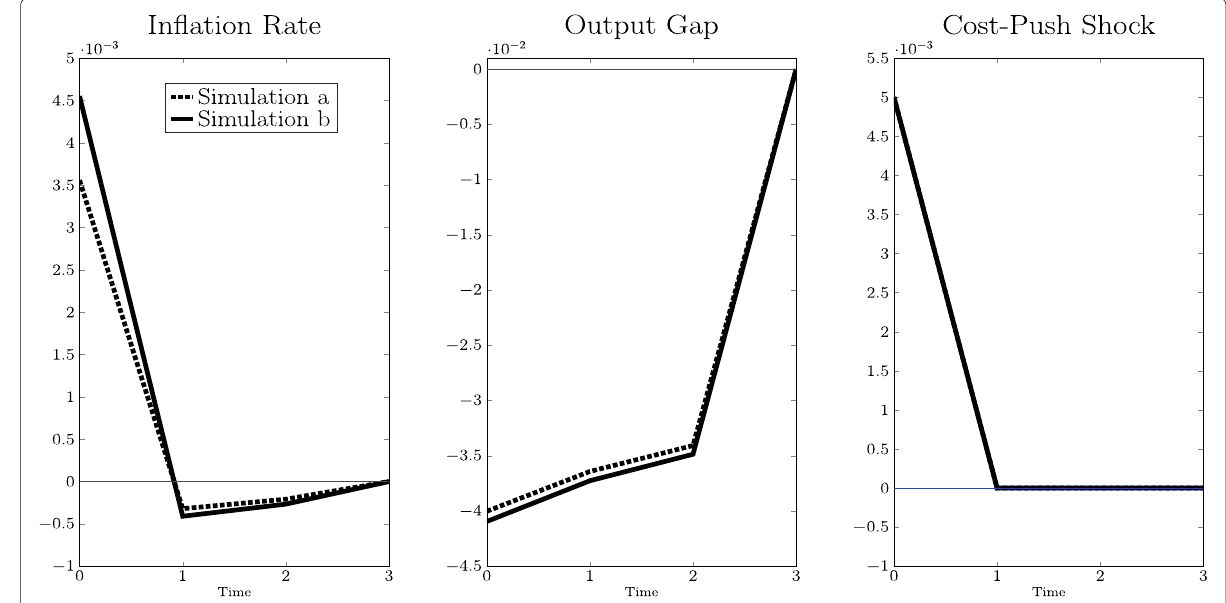
(cid:15) (cid:16) T + 1 γ a = { 1,1,1,0 } and simulation b (solid lines) assumes central bank credibilities t t = 0 } T + 1 = { H ,0,0,0 } and ρ = 0. To highlight the difference in the t u t = 0